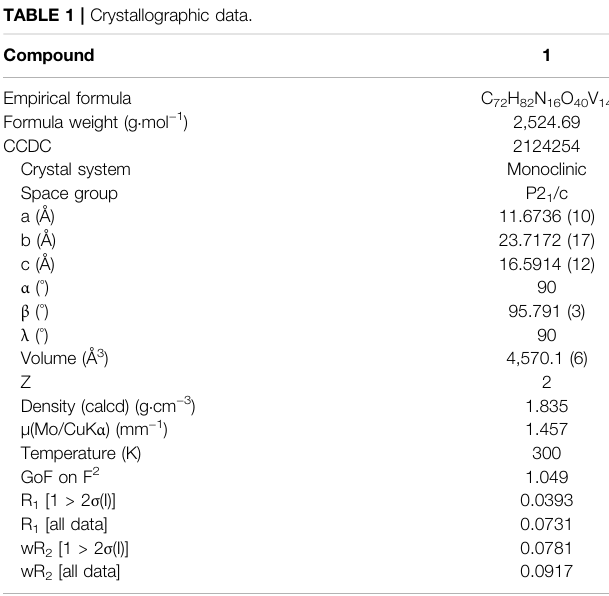
TABLE 1 | Crystallographic